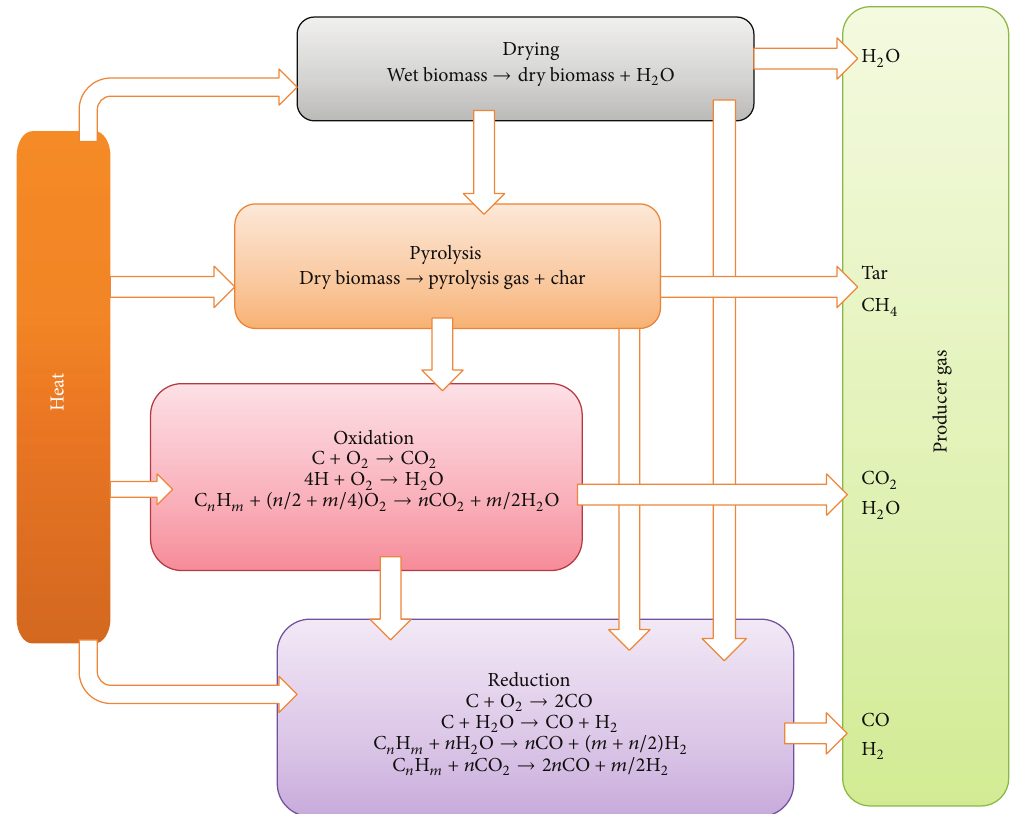
Figure 1: The reaction mechanism of biomass gasification process